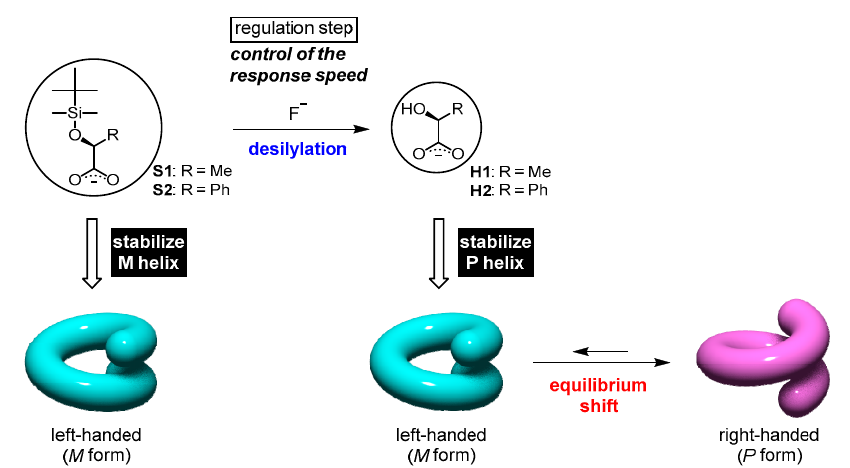
Figure 10. Response speed control of helicity inversion of L 2 Zn 3 La using desilylation of coordinating siloxycarboxylate ions ( S1 , S2 ).